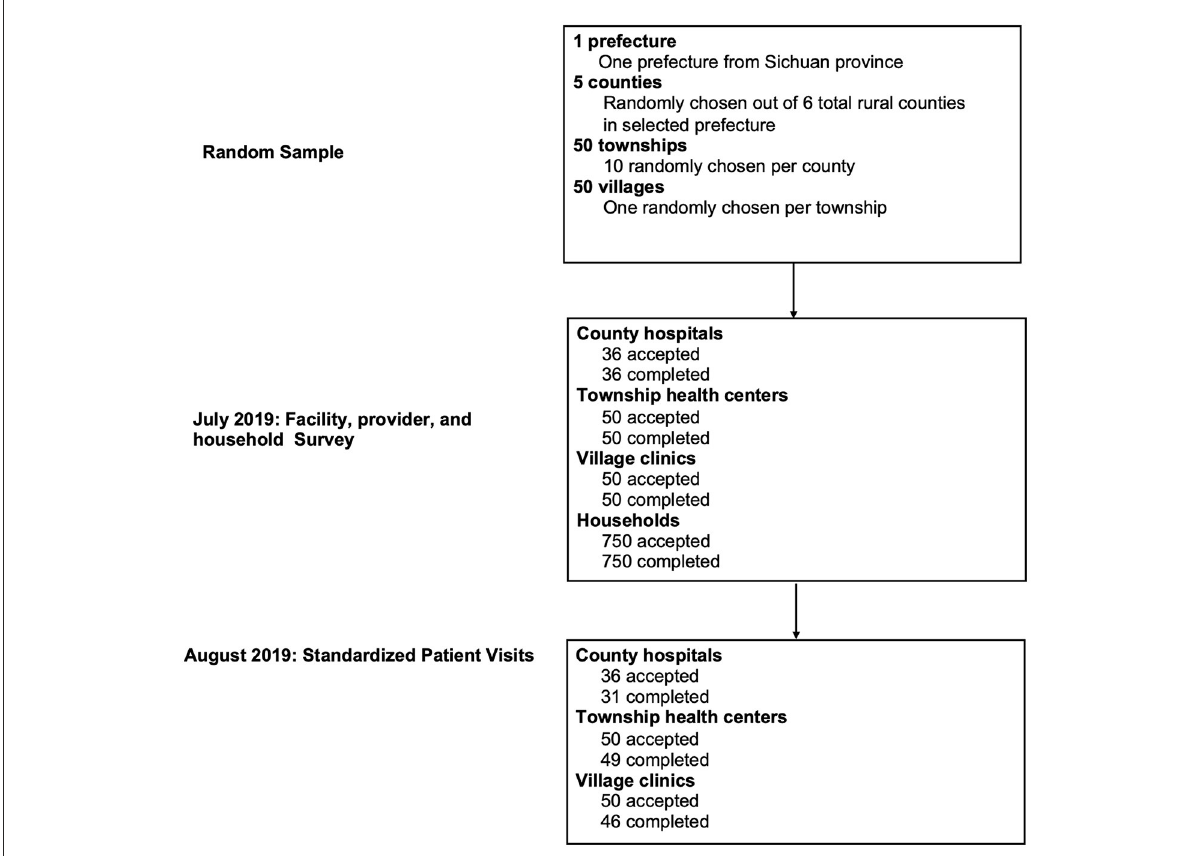
FIGURE1 STROBE flowchart. Standardized patients were randomly assigned to facilities and within each facility, standardized patients visited the provider following normal procedures for walk-in patients. Fifteen households were randomly selected from the resident roster of each sample village, totaling 750